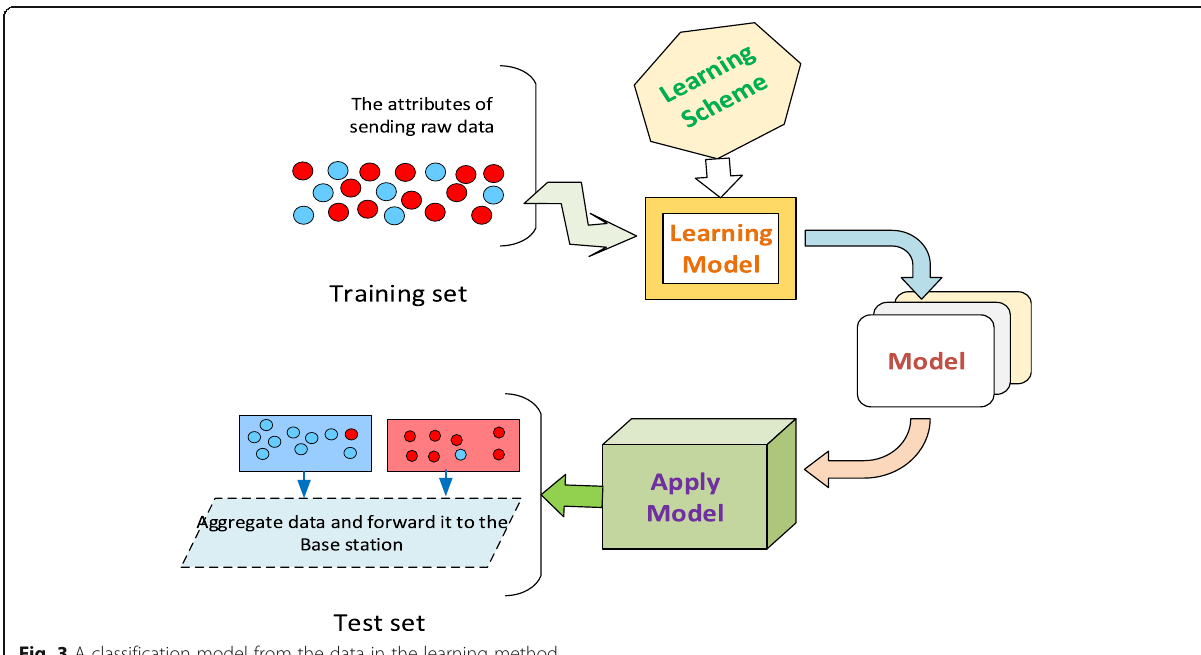
Fig. 3 A classification model from the data in the learning